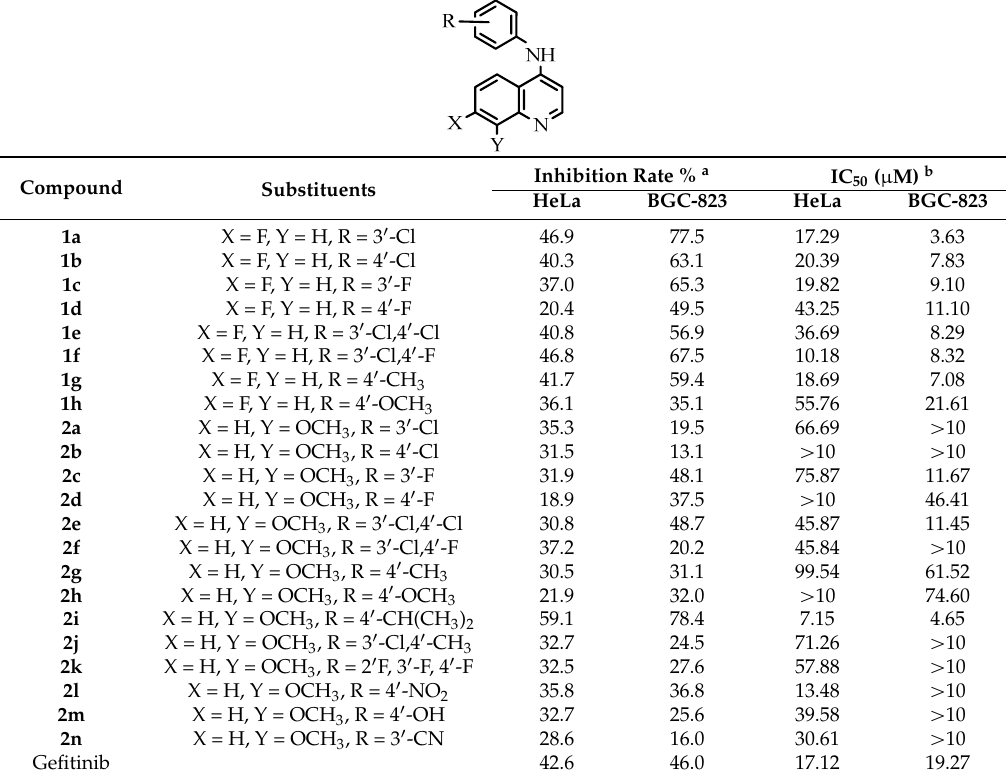
Table 1. Antiproliferactive activity of the target compounds on HeLa and BGC-823 cell lines.